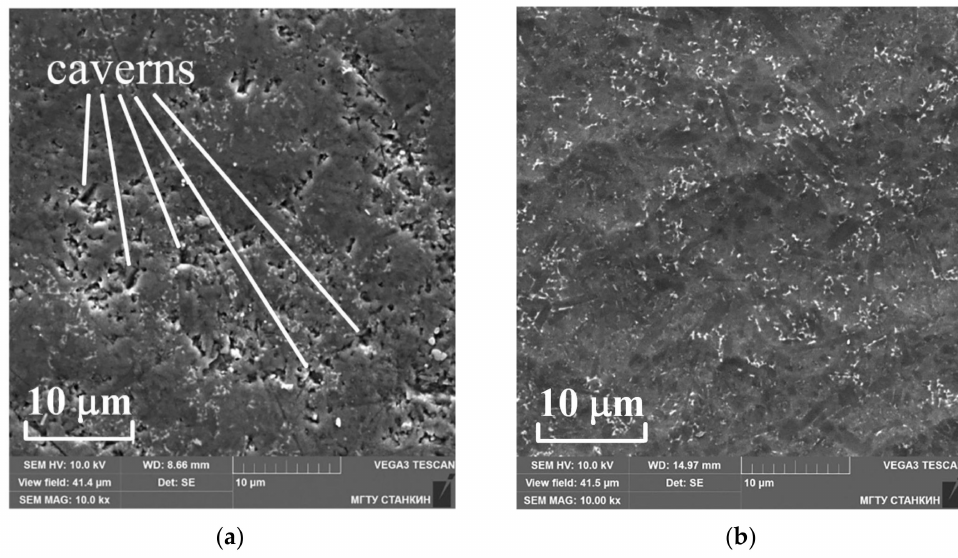
Figure 8. SEM images of the cutting plate surface ( a ) with deep caverns before processing and ( b ) without caverns after removal of a 10 µ m-thick surface layer by fast argon